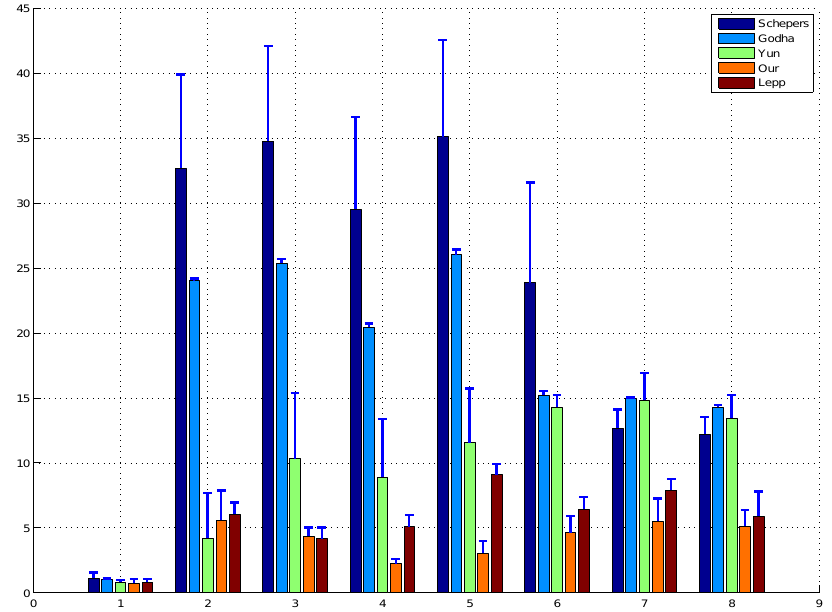
Figure 7. Outdoor walking: the average and standard deviation of distance errors between the estimated positions and actual positions of the 8 critical points over 5 trials. For the traditional methods without map information, the distance errors had significant increment as the walking distance increased due to acceleration integration